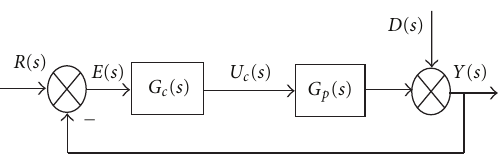
Figure 2: Block diagram of the closed loop control system.